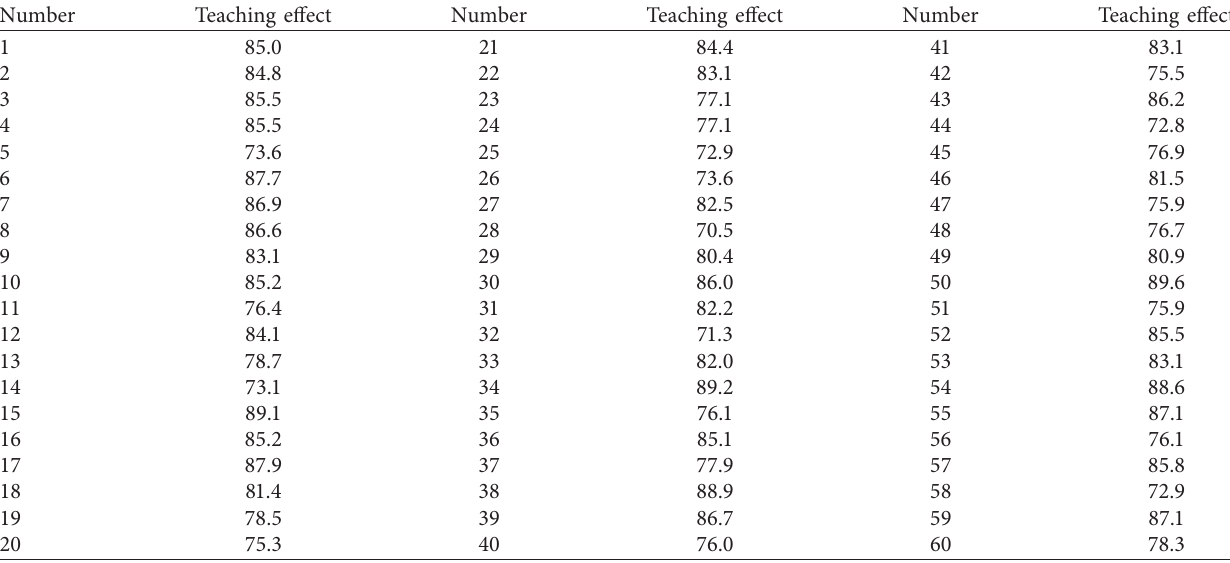
Table 2: Evaluation of the teaching effect of the system.